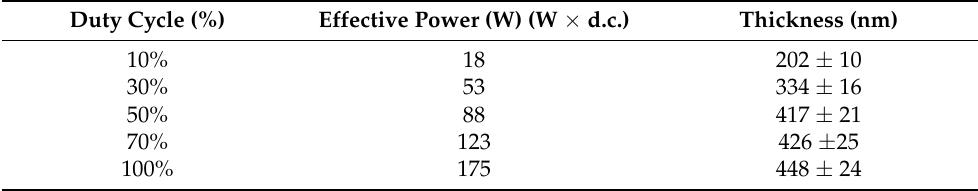
Table 2. Thickness of pulsed PPOLs, the values were collected at different d.c. conditions. For each plasma coating, three samples were prepared; the values of the thickness are the average of three measurements. Duty Cycle (%) Effective Power (W) (W × d.c.)